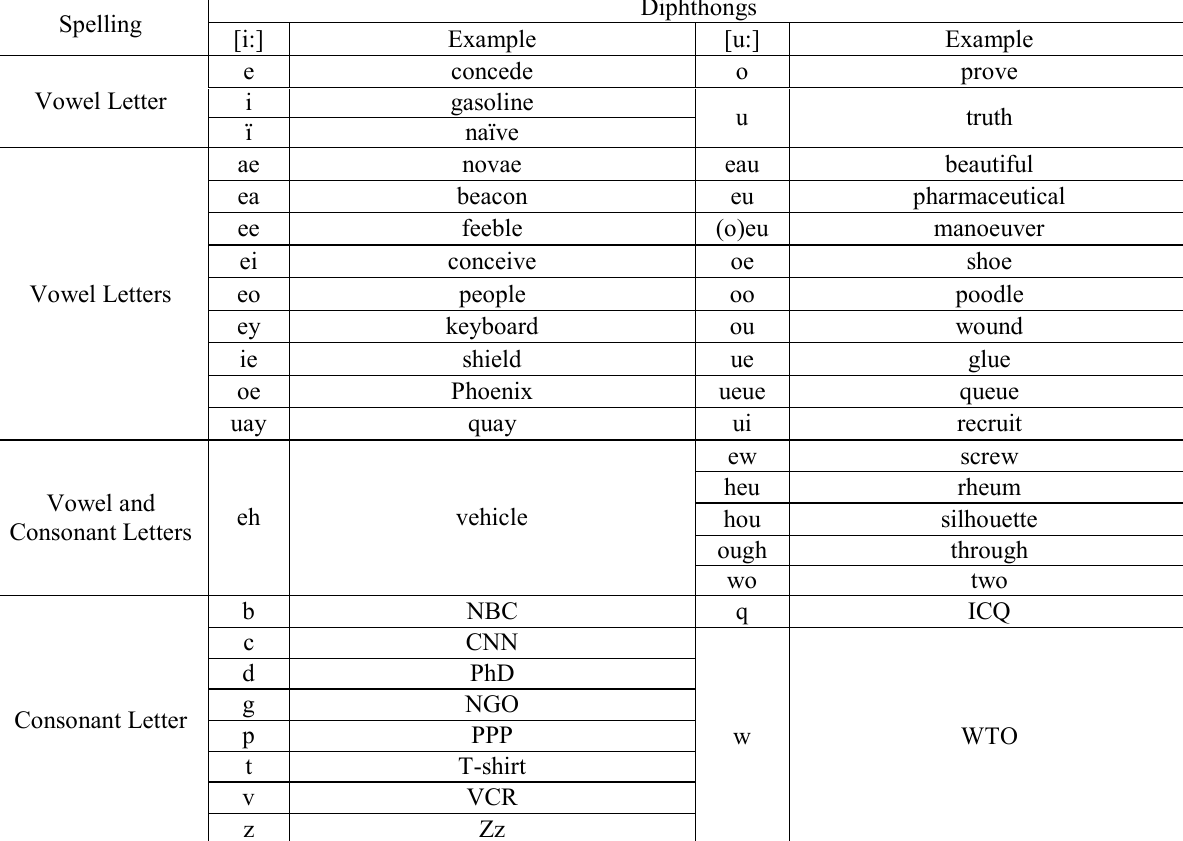
Table 5. Ways of Graphical Spelling of Diphthongoids [i:] and